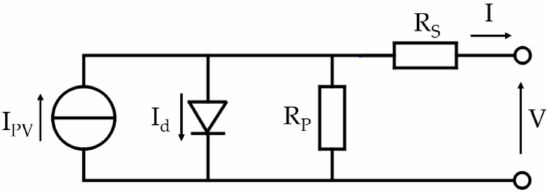
Figure 3. Single-Diode Model (SDM) equivalent circuit of a photovoltaic (PV)